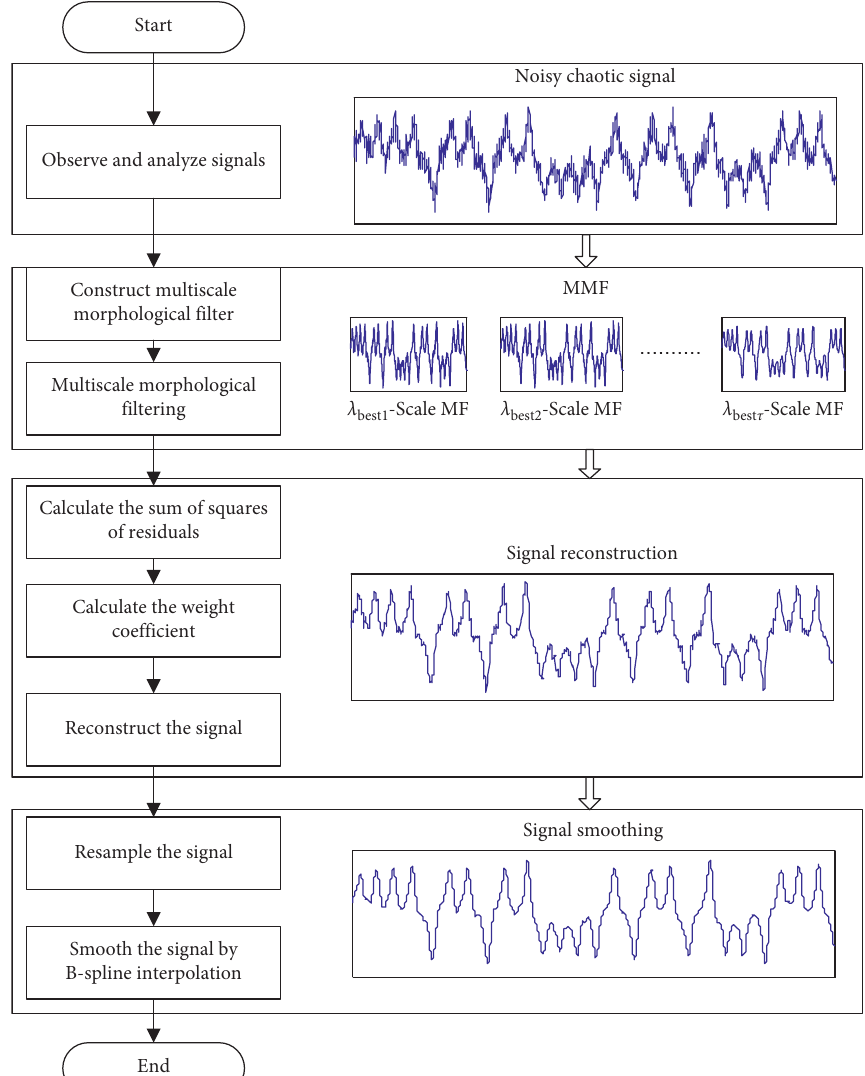
Figure 1: Flowchart of the denoising algorithm for chaotic signals based on